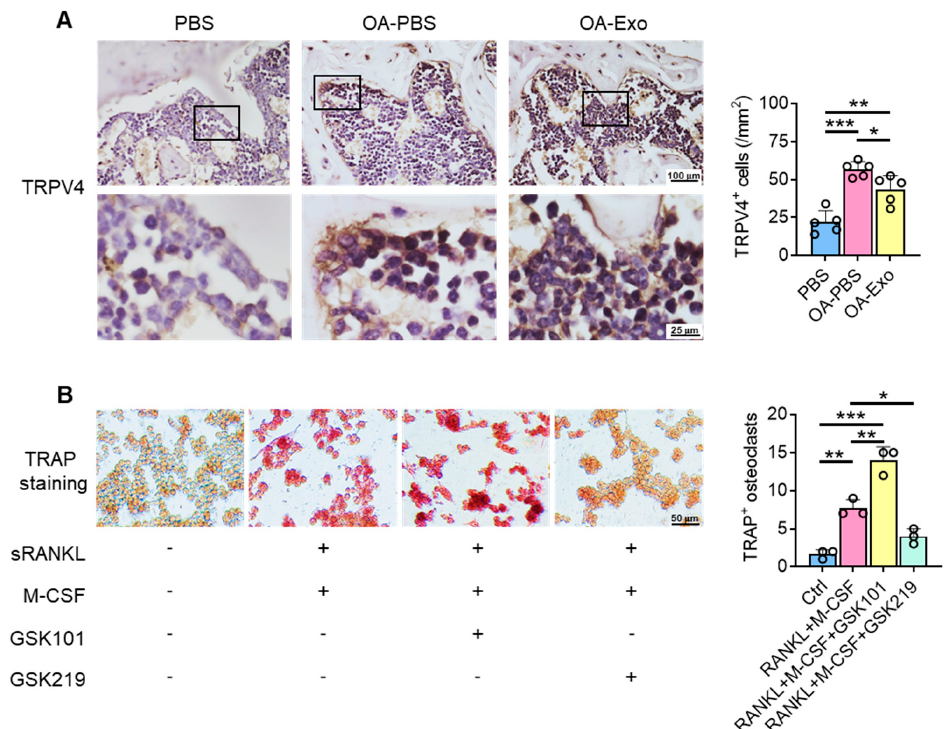
Figure 5. DPSC-Exos regulated osteoclast activation via TRPV4. ( A ) Representative images of TRPV4 in the subchondral bone by IHC staining. Data are presented by mean ± SD. * p < 0.05, ** p < 0.01, *** p < 0.001; n = 5. ( B ) Representative images of RAW 264.7 cells by TRAP staining after TRPV4 activation/inhibition. The data were collected from three independent samples and are presented by mean ± SD. * p < 0.05, ** p < 0.01, *** p < 0.001.